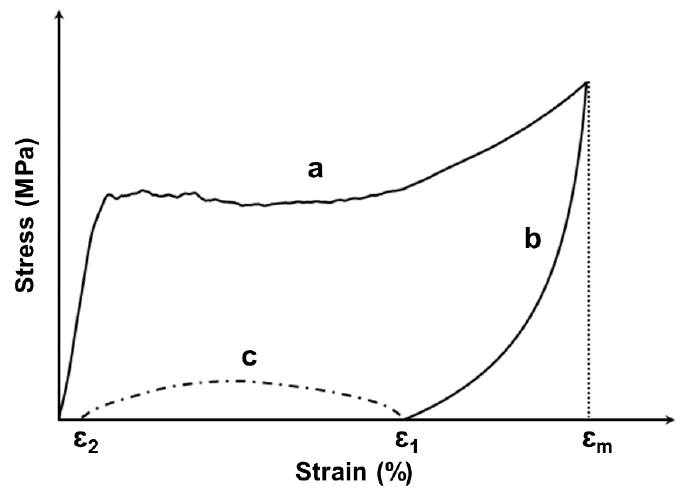
Figure 4. Illustration of a typical shape memory cycle.